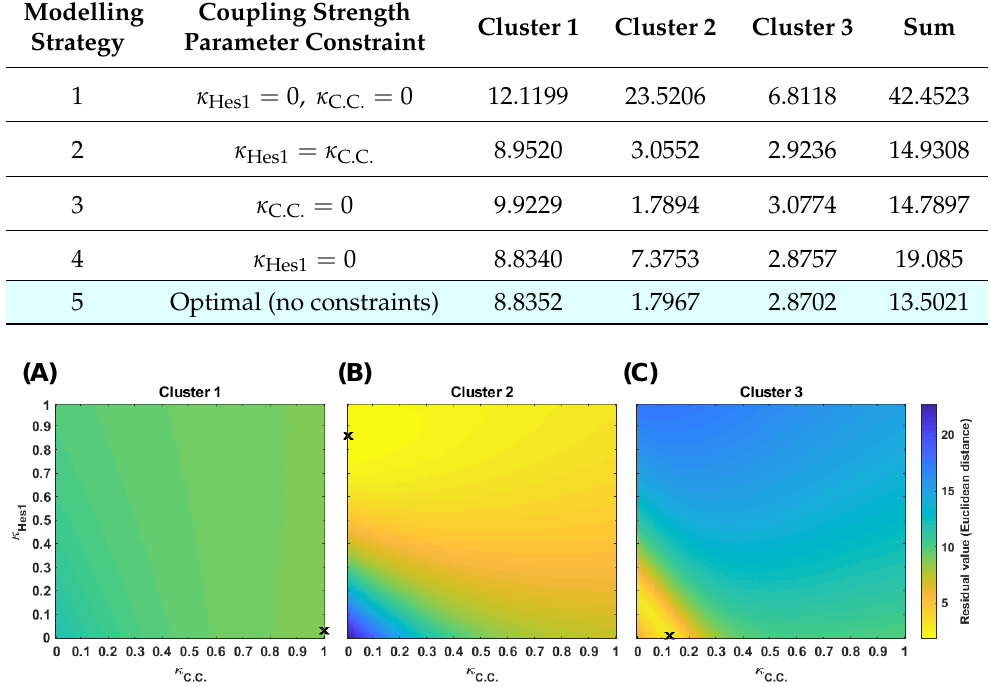
Figure 8. Heatmaps of two-dimensional κ C.C. × κ Hes1 parameter space with the colour representing the residual value (Euclidean distance) between solution vector θ i = 1,2,3 in panels ( A–C ) respectively, in the case with no parameter constraints. The black x marks the point in this space where the residual is the lowest for each cluster, i.e., the coupling strength parameter values that yielded the best fit to the data and thus those used to produce the results in Figure